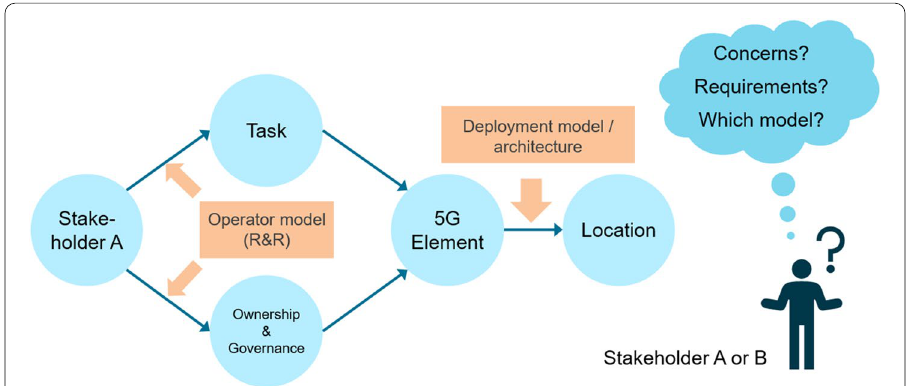
Fig. 13 The view of stakeholders on operator